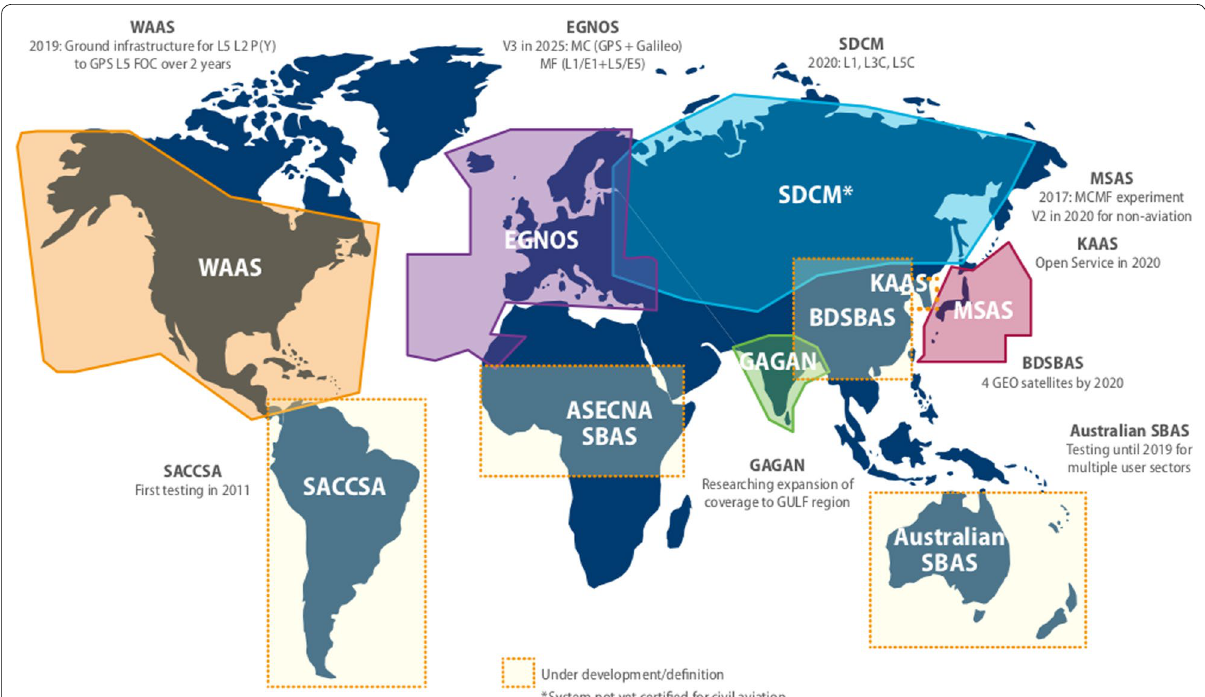
Fig. 6 Existing and satellite-based augmentation systems (SBAS) under development. Reference: https ://www.gsa.europ a.eu/sites /defau lt/files / broch ure_o_2017_v6.pdf (figure